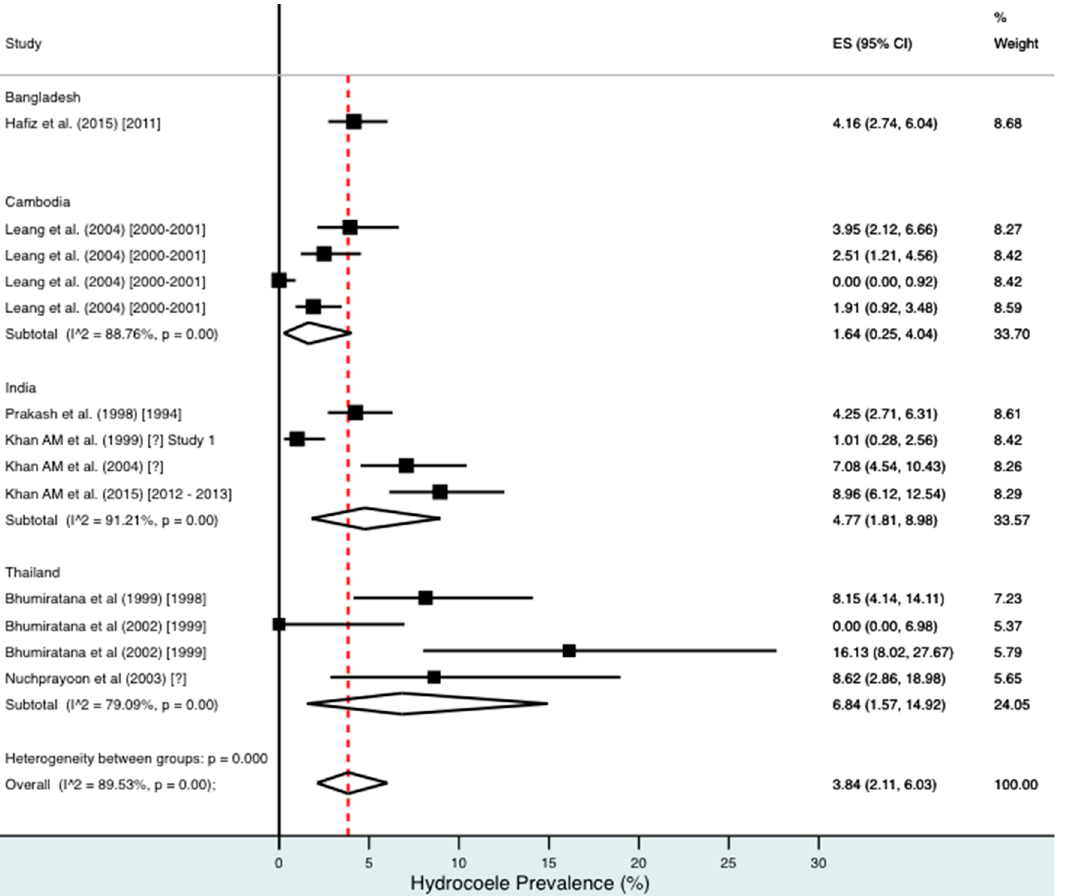
Figure 5. Percentage estimates of hydrocoele prevalence by country and year. ES: prevalence estimate. Red-dotted line: overall estimate. Diamond: sub-group estimate. Horizontal line: 95% CI.